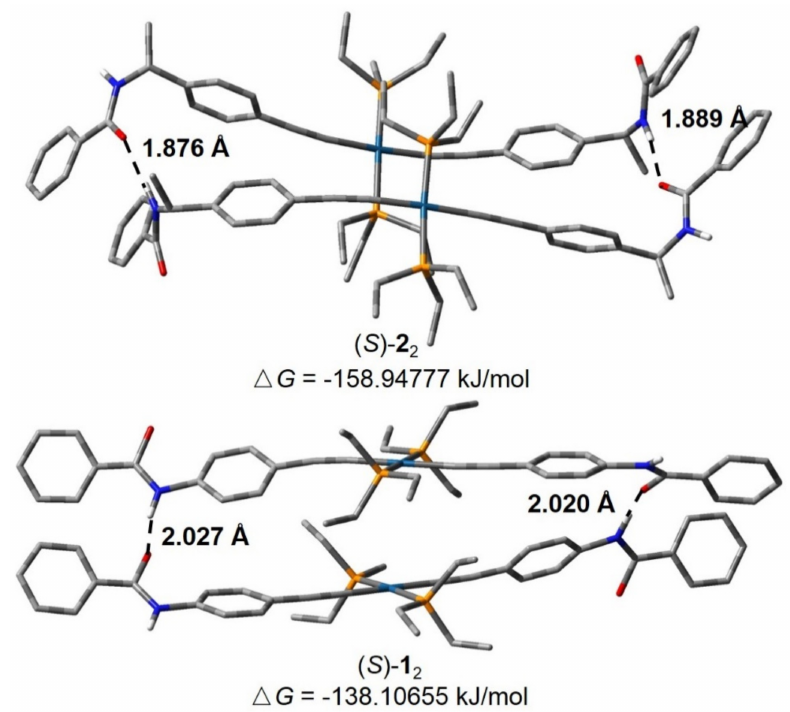
Figure 2. Optimized dimeric structures of ( S )- 2 2 and ( S )- 1 2 on the basis of DFT